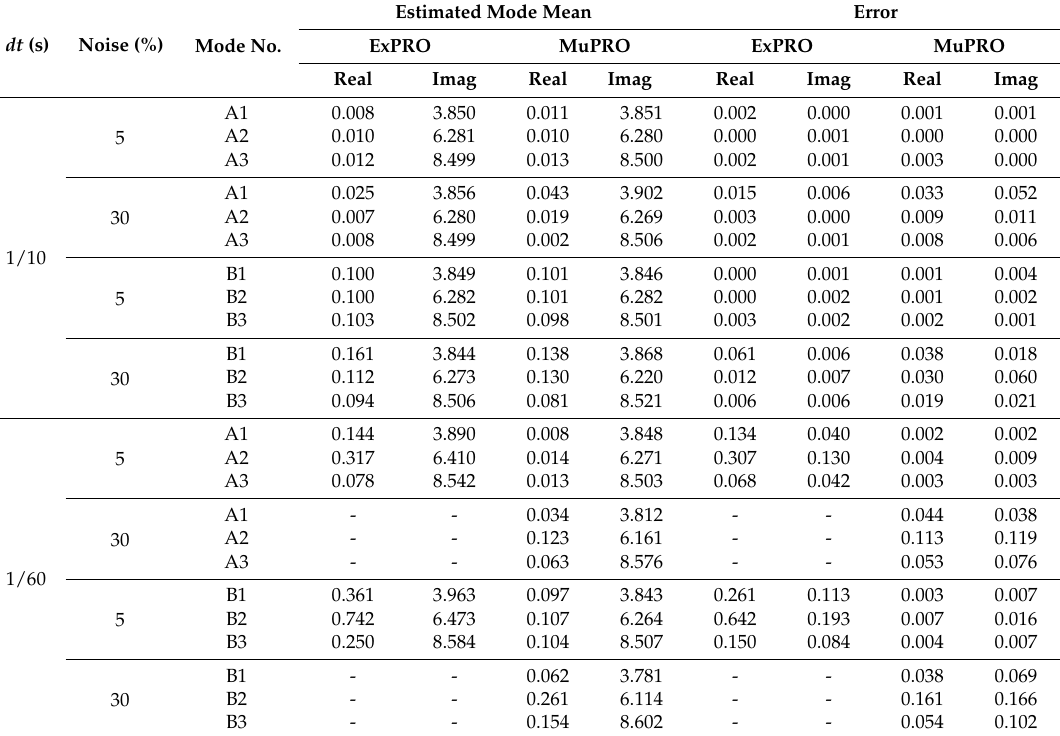
Table 2. Estimated mode mean and